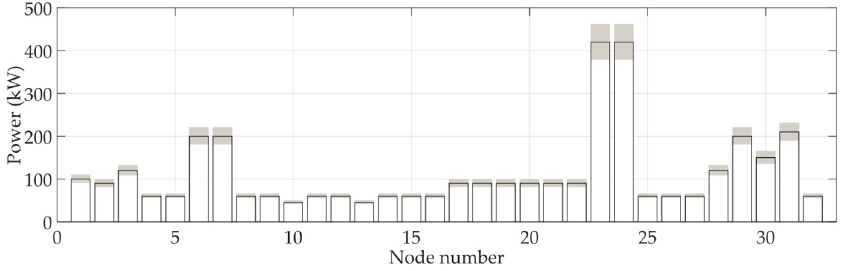
(cid:48) power Figure 6. Prediction of nodes ʹ power curves . Figure 6. Prediction of nodes Figure 6. Prediction of nodes ʹ power curves .